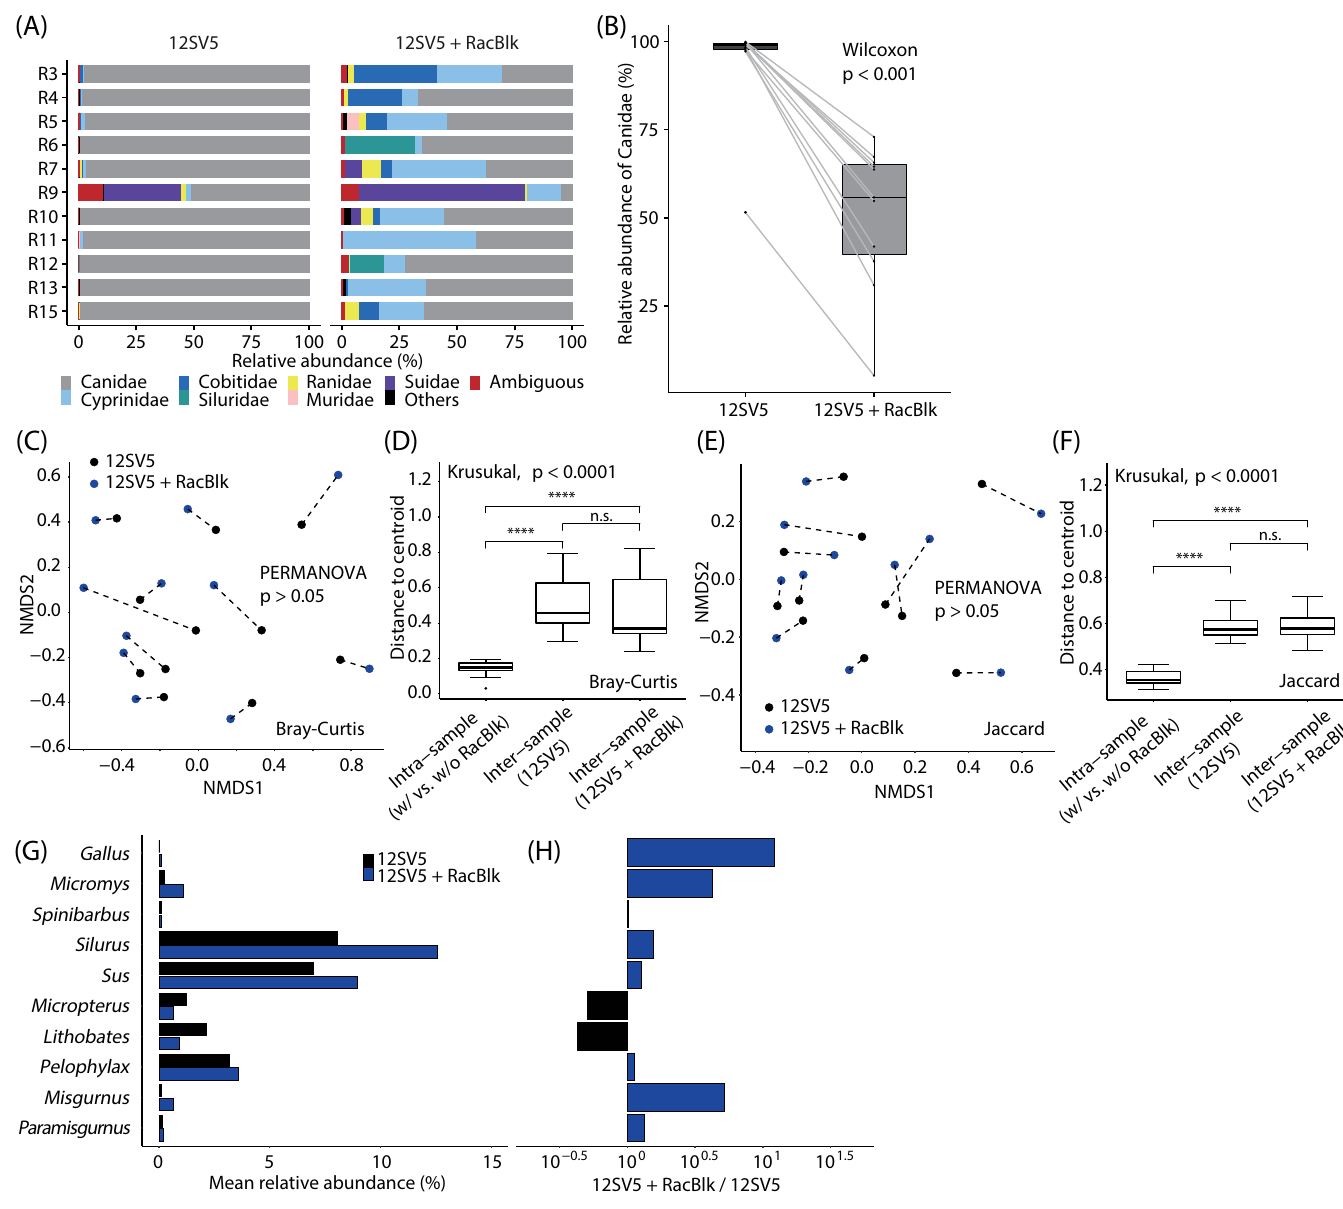
ParamisgurnusMisgurnusPelophylaxLithobatesMicropterusSusSilurusSpinibarbusMicromysGallus Fig 1. Performance of blocking oligonucleotide RacBlk. The 12S rRNA gene libraries prepared with the universal vertebrate primer pair 12SV5 are compared with and without RacBlk. (A) Relative abundance of vertebrates identified at the family level. (B) Relative abundance of Canidae to which the raccoon dog belongs. (C) Non-metric multidimensional scaling (NMDS) plot showing the Bray–Curtis dissimilarity of community structure of prey animals with and without RacBlk. (D) Boxplot showing the intra- and inter-sample variances of the Bray–Curtis dissimilarity of prey composition. (E) NMDS plot showing the Jaccard index of community membership of prey animals with and without RacBlk. (F) Boxplot showing the intra- and inter-sample variances of the Jaccard index of prey membership. (G) Mean relative abundances of the top 10 vertebrate genera detected with and without RacBlk. The reads identified as sequences of Canidae were excluded from the calculation of relative abundance. (H) Ratio of mean relative abundances measured with and without RacBlk. In the panels (C) and (E), the data from the same sample were connected by a line. In the panels (D) and (F), the four asterisks ( ���� ) represent p < 0.0001 by the post hoc Wilcoxon rank-sum test. The abbreviation “n.s.” represents that there is no significant difference.